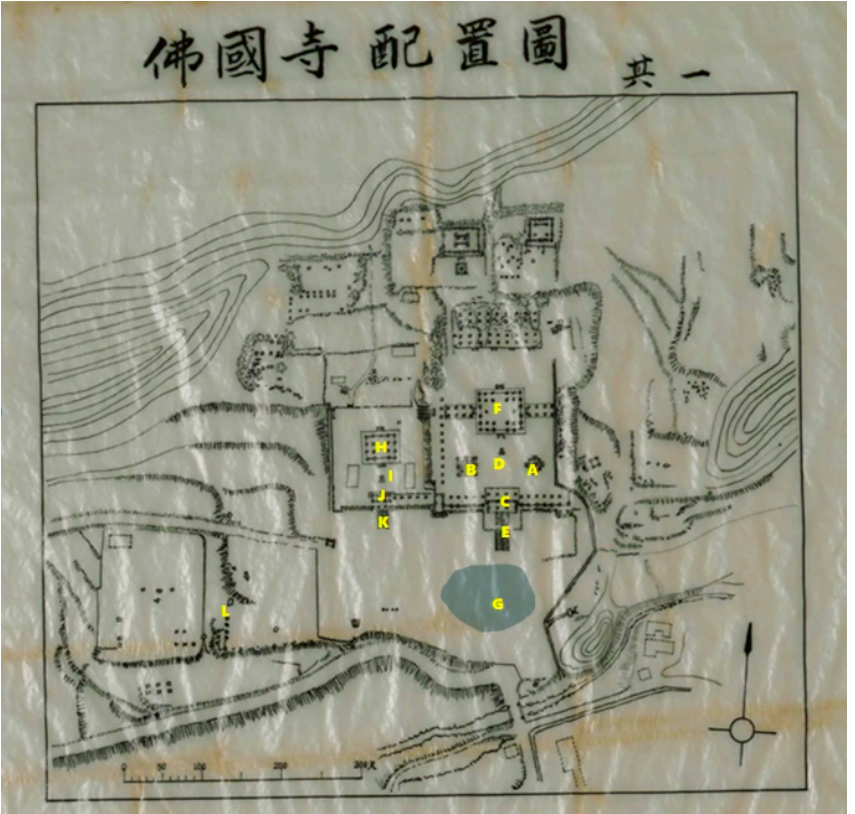
Figure 2. Lotus Pool (Nine Ranks for Rebirth) and Building Remains after 1924 (Gukga girokwon). A: East Pagoda (Dabotap), B: West Pagoda (Seokgatap), C: Gate (Jahamun), D: Worship Stone, E: Bridges and Platforms (Cheogungyo and Baekun Bridges), F: Mahavira Hall (Daeungjeon Hall), G: Lotus Pool (Pond), H: Amitabha Hall (Geukrakjeon